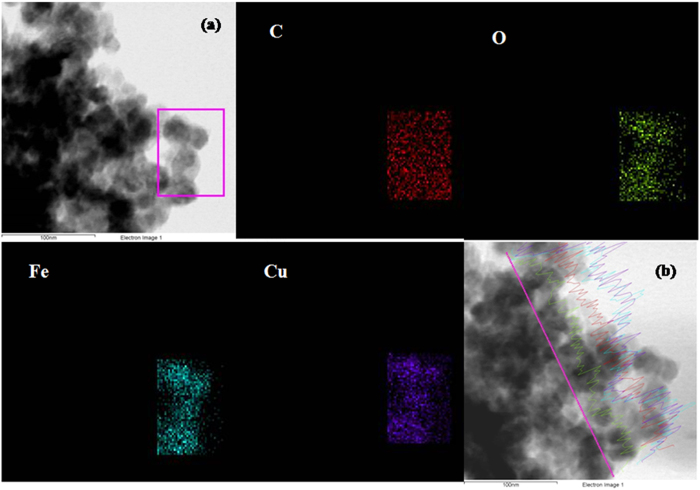
EDS mapping of (a) GO-CuFe2O4 nanocomposite and (b) EDS line scan of GO-CuFe2O4 nanocomposite.